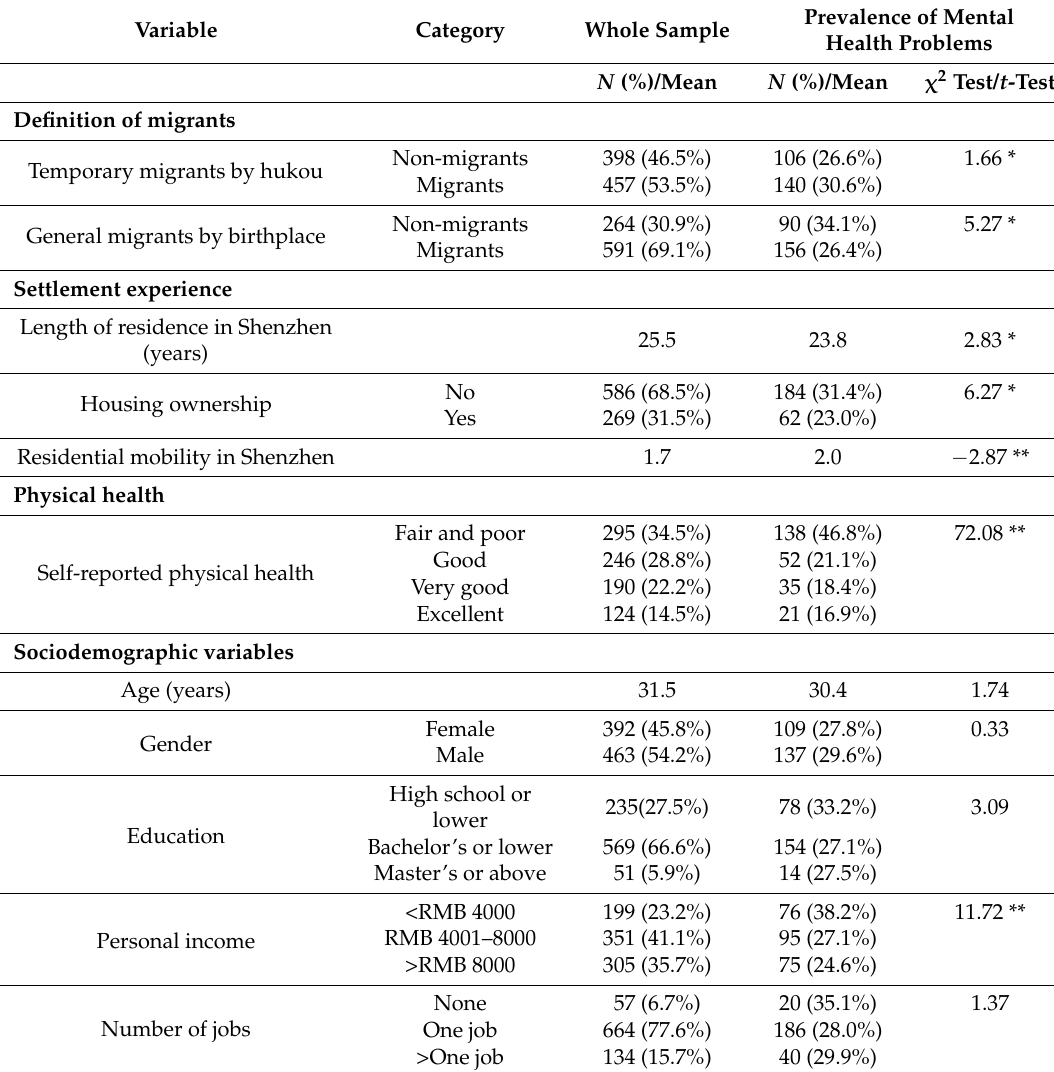
Table 1. Descriptive statistics and mental health prevalence